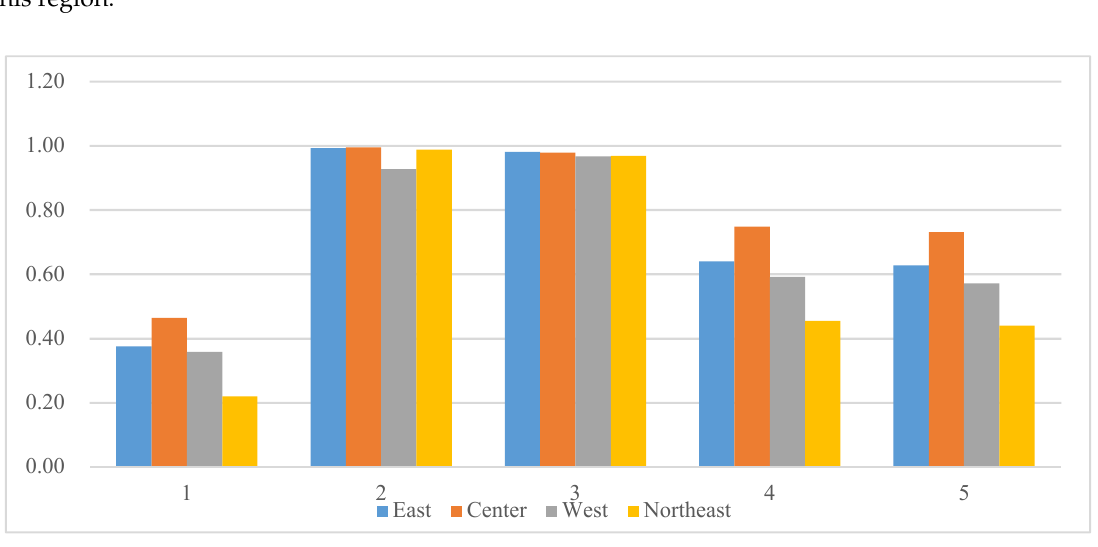
Figure 1. Estimated energy use efficiency by regions (2010–2017).